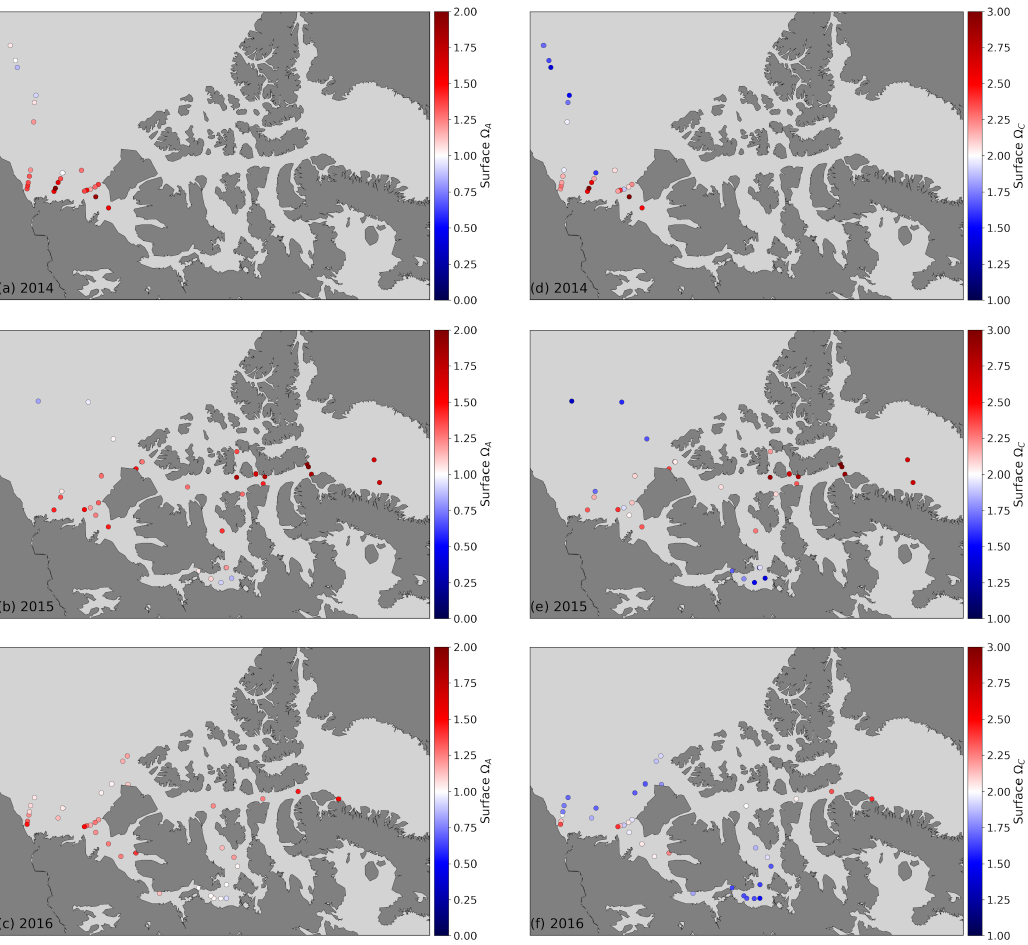
Figure 5. Surface water ( < 10m) (cid:127) A (a, b, c) and (cid:127) C (d, e, f) in 2014 (a, d) , 2015 (b, e) and 2016 (c, f) . Note the different colour scales for (cid:127) A and (cid:127) C , for which the diverging value for the former is 1 and is 2 for the